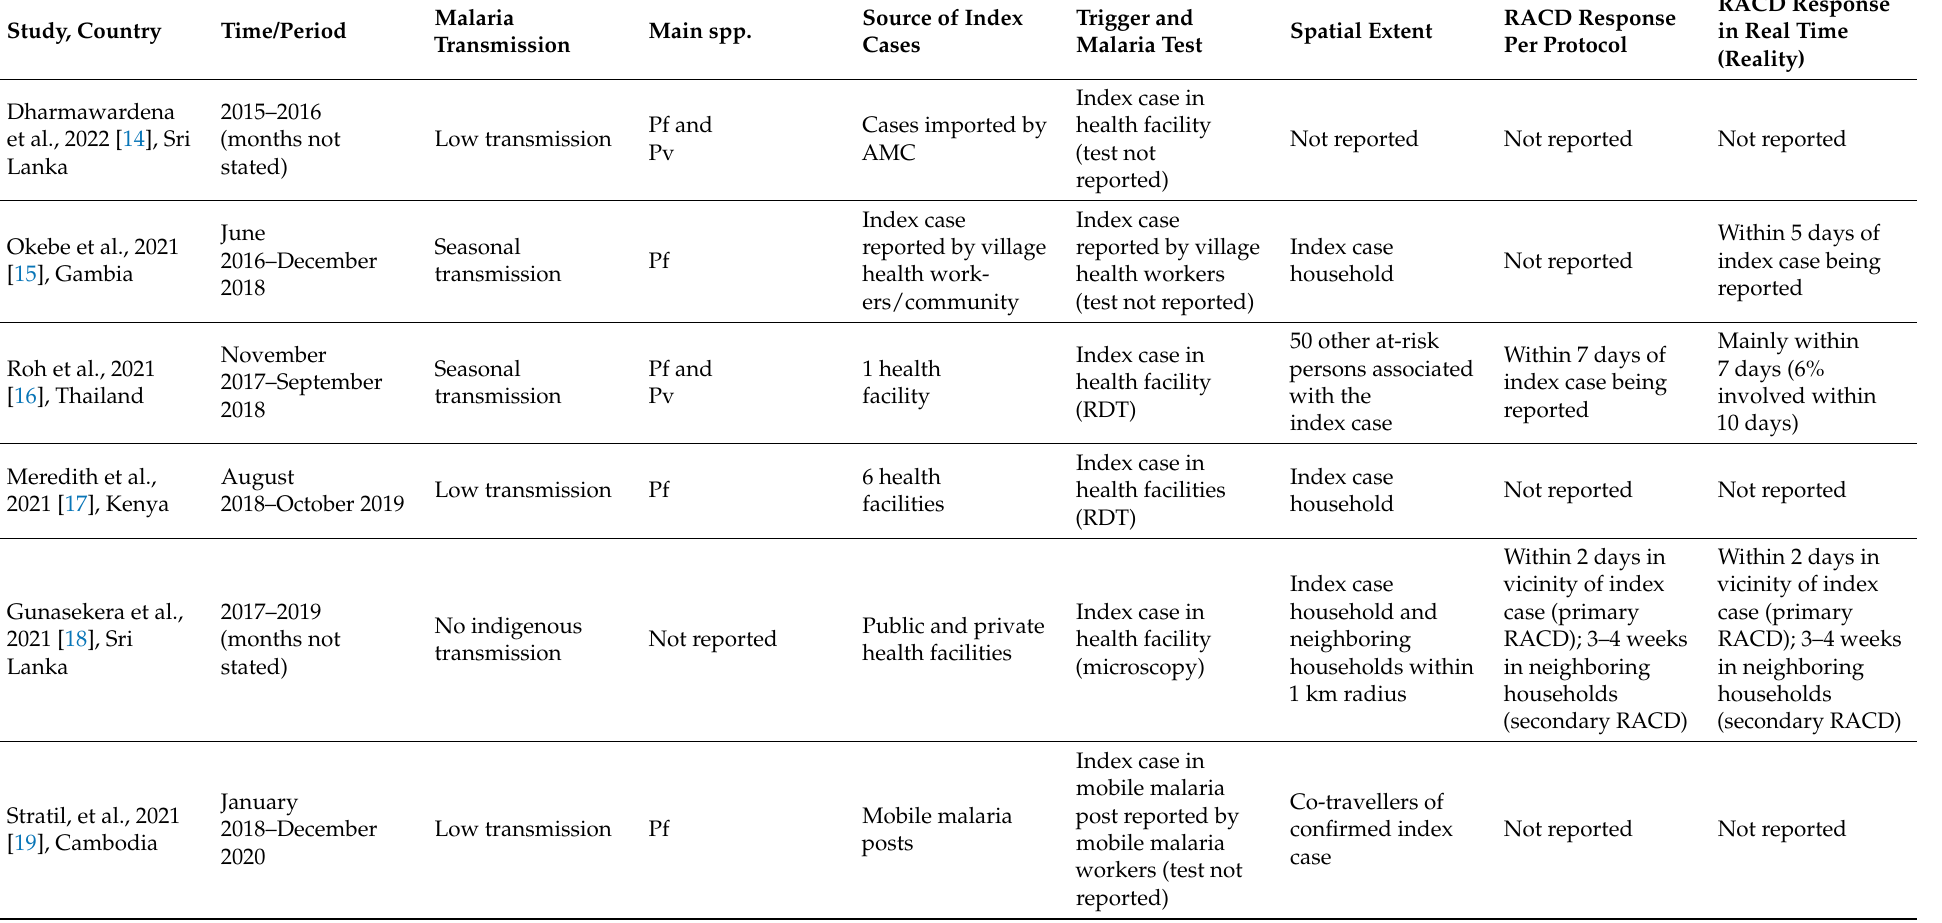
Table 1. Summary of included